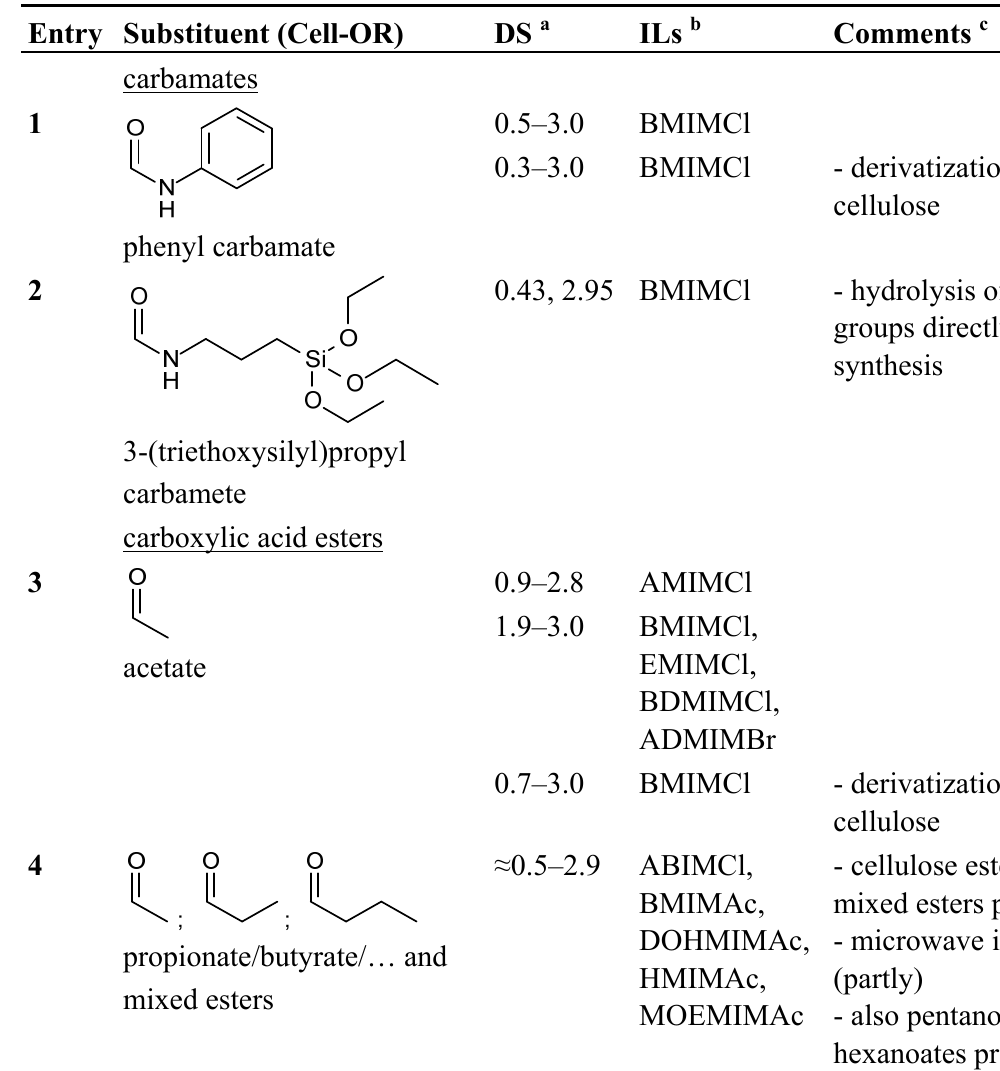
Table 1. Overview over cellulose derivatives, in ionic liquids